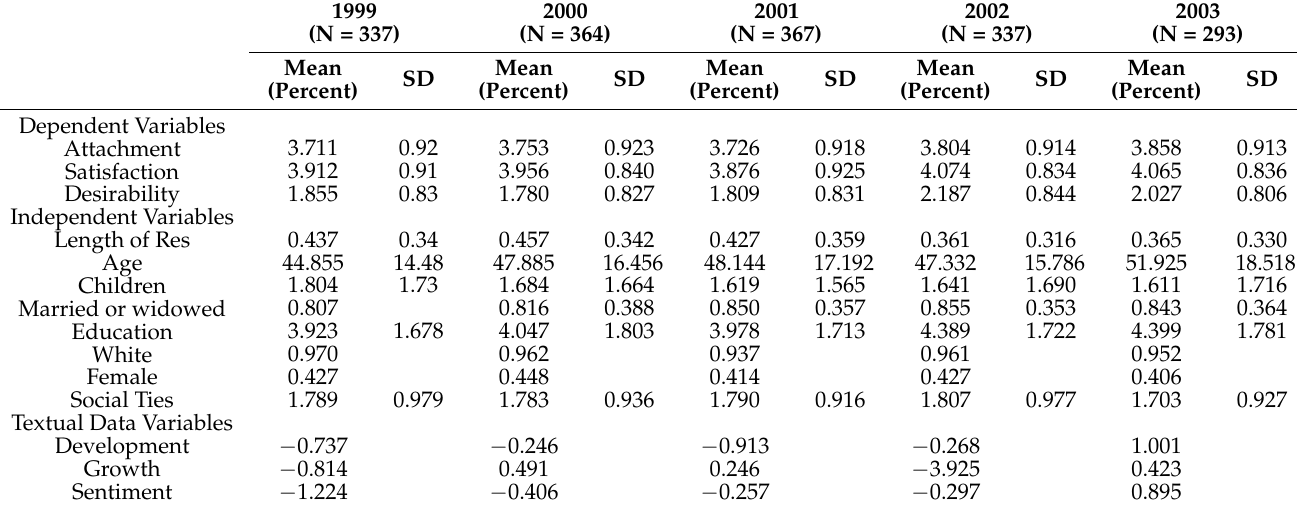
Table 1. Descriptive